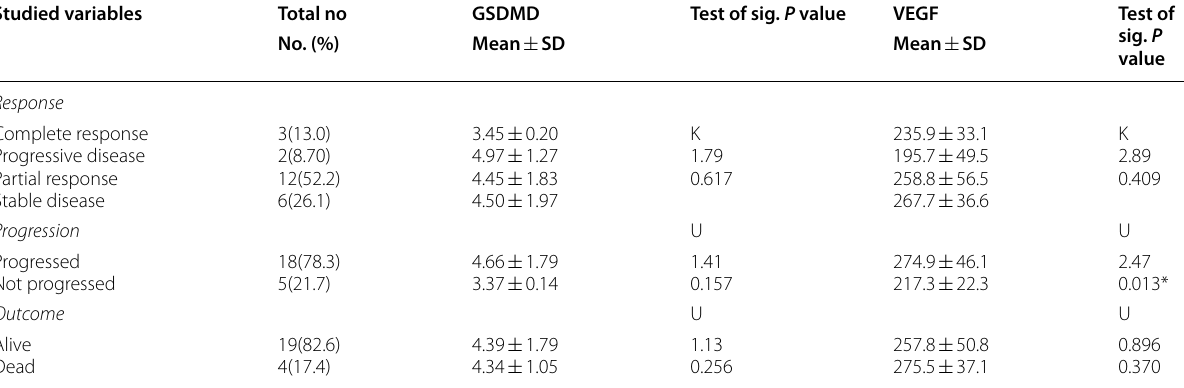
U : Mann–Whitney test K : Kruskal–Wallis test, * significant